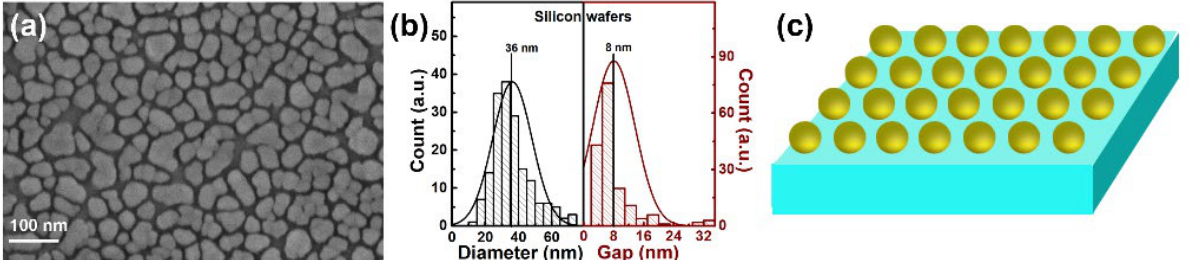
Figure 4. SEM images ( a ), statistical histograms for the diameters ( b ), and schematic diagram of the Ag NPs on the surface of Si substrate ( c ).